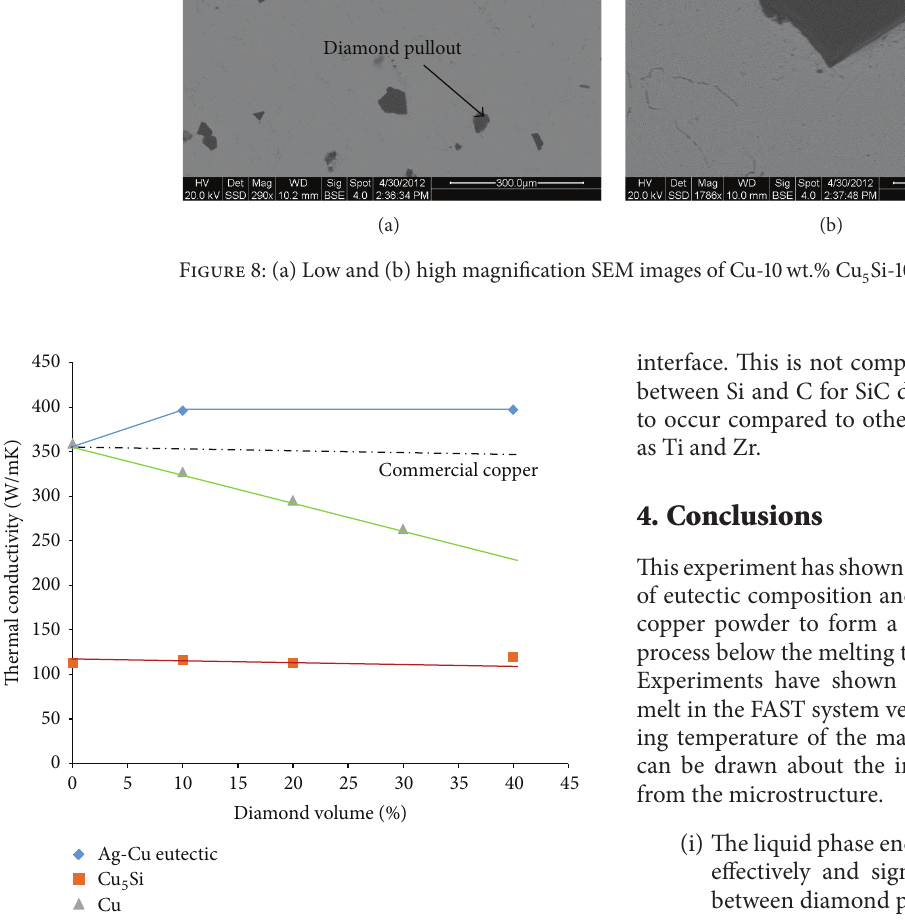
Figure 9: Thermal conductivities of Cu, Cu-Ag72Cu, and Cu-Cu 5 Si systems with diamond